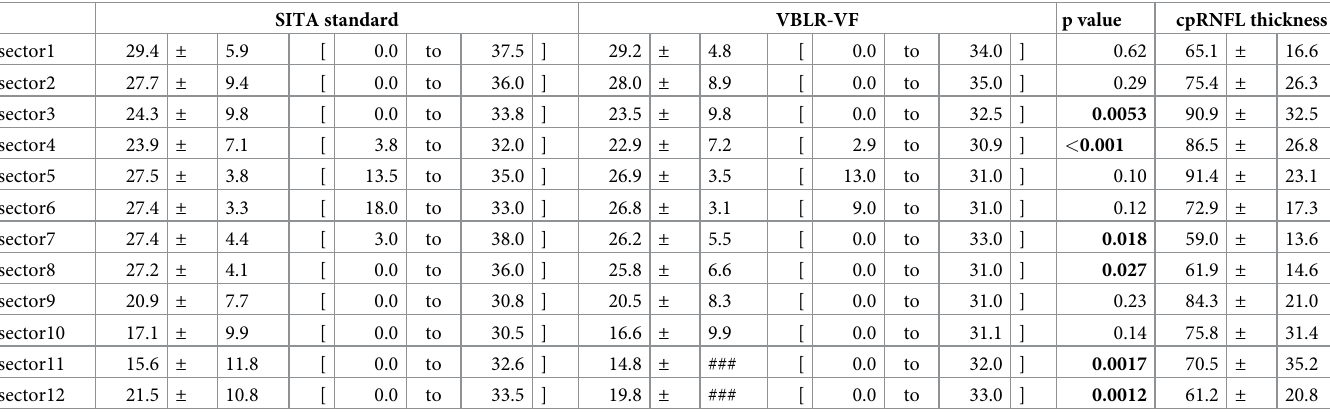
Table 2. Average visual sensitivities and cpRNFL thickness in 12